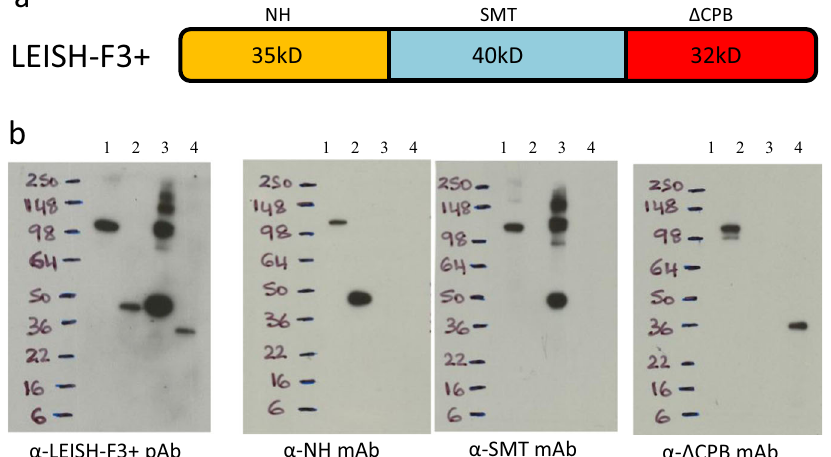
Fig. 2 Construction and characterization of the LEISH-F3+ fusion protein. In a , a cartoon depiction of the LEISH-F3+ fusion protein is shown. In b , LEISH-F3+ fusion protein was characterized by immunoblot. Recombinant LEISH-F3+ ( lane 1 ), Nucleoside hydrolase ( NH ; lane 2 ), Sterol-24-c- methyl-transferase ( SMT ; lane 3 ) or truncated cysteine protease B protein ( Δ CPB ; lane 4); were loaded at 100 ng each lane into gels. Blots were developed with mouse polyclonal or monoclonal antibodies as indicated, derived from the same original gel. The cartoon depiction of the fusion protein is the authors own